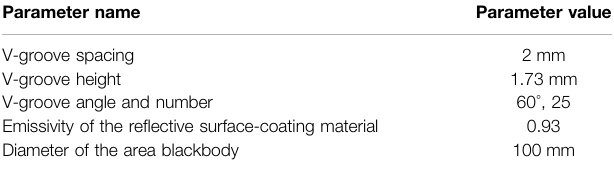
TABLE 1 | V-groove model parameters.